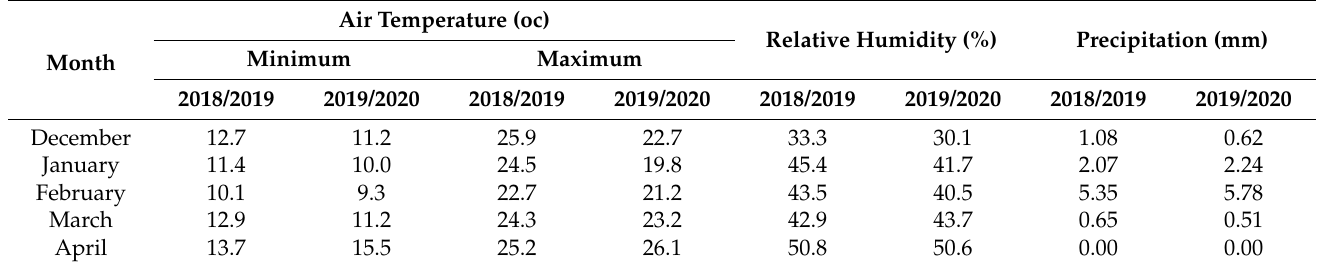
Table 2. Means monthly of climatic parameters during barely growth and development at the